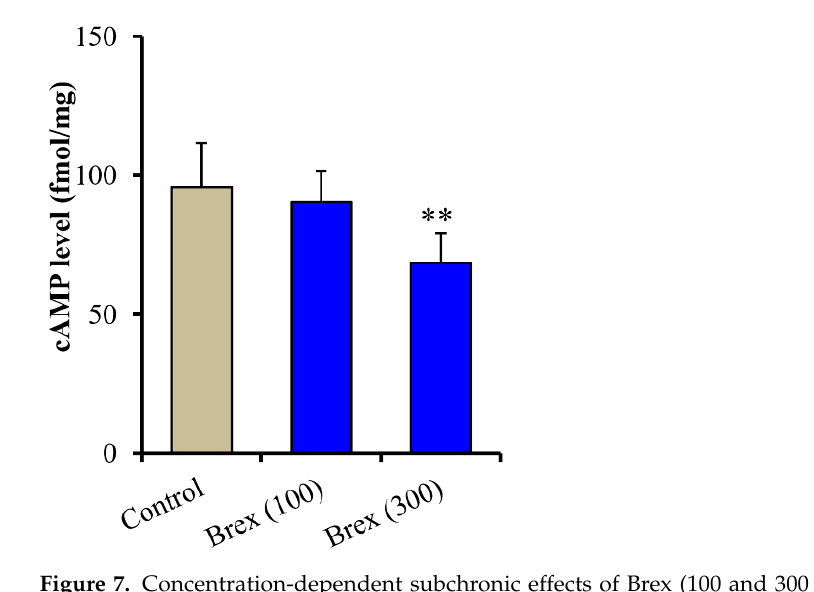
Figure 6. Concentration-dependent acute effects of Brex (100 and 300 nM) on intracellular cAMP level in astrocytes (panel A ). Interaction among therapeutic relevant concentration of Brex (100 and 300 nM), 5 μ M AS19 (5-HT7R agonist) (panel B ) and 10 μ M WAY100635 (5-HT1AR antagonist) (panel C ) on intracellular cAMP level in astrocytes. Ordinates indicate mean ± SD ( n = 6) of intracellular cAMP level in cultured astrocytes (fmol/mg). * p < 0.05, ** p < 0.01: relative to control (Brex-free) by one-way ANOVA with Tukey’s post-hoc test.